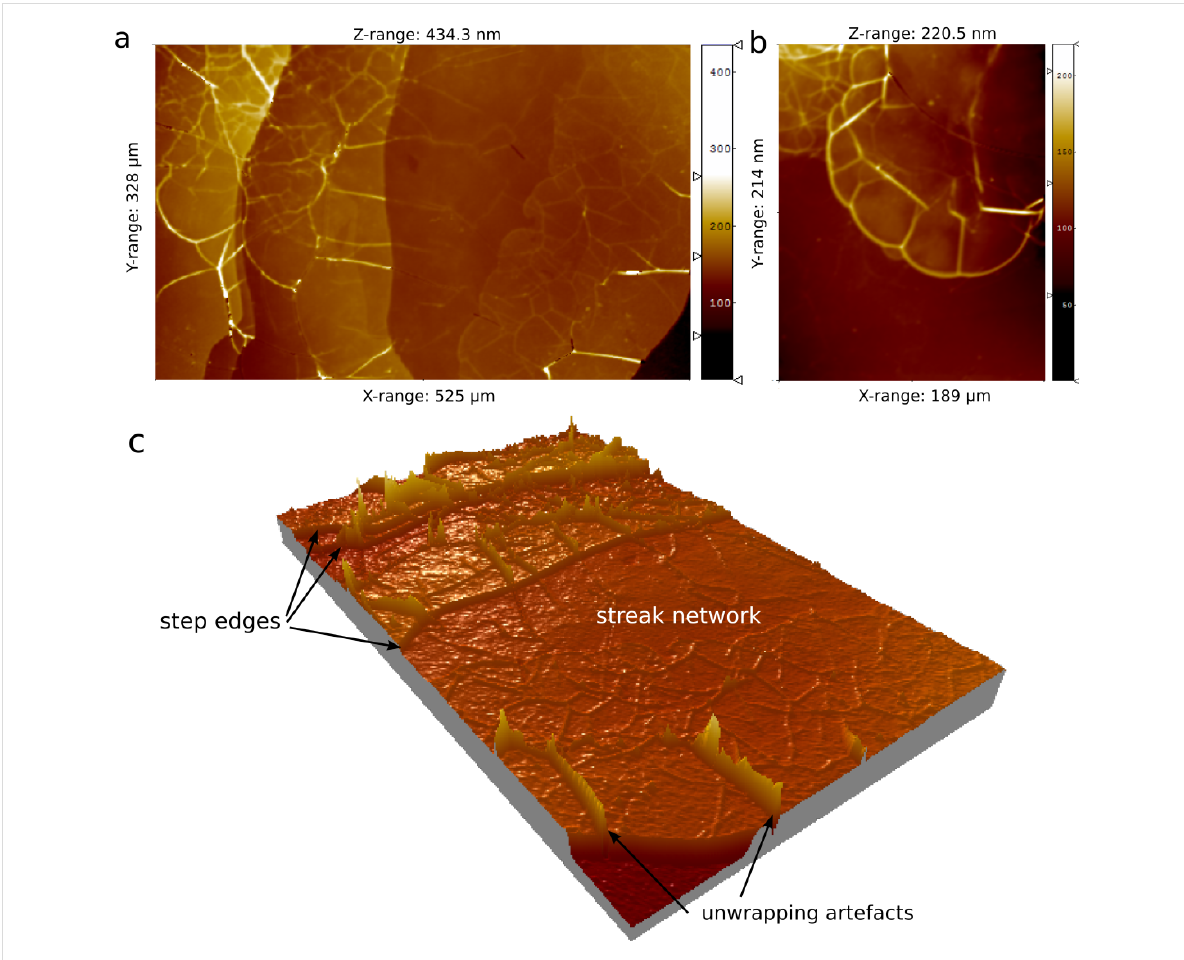
Figure 4: Unwrapped phase shift interferograms of a reacted biotite (001) surface at pH 9.5 and 50 °C after about 3 d: a) 2D image that shows high (80–100 nm) and low (8–10 nm) streaks, which spread from step edges; b) 2D image that shows low streaks in more detail; c) 3D image of a).